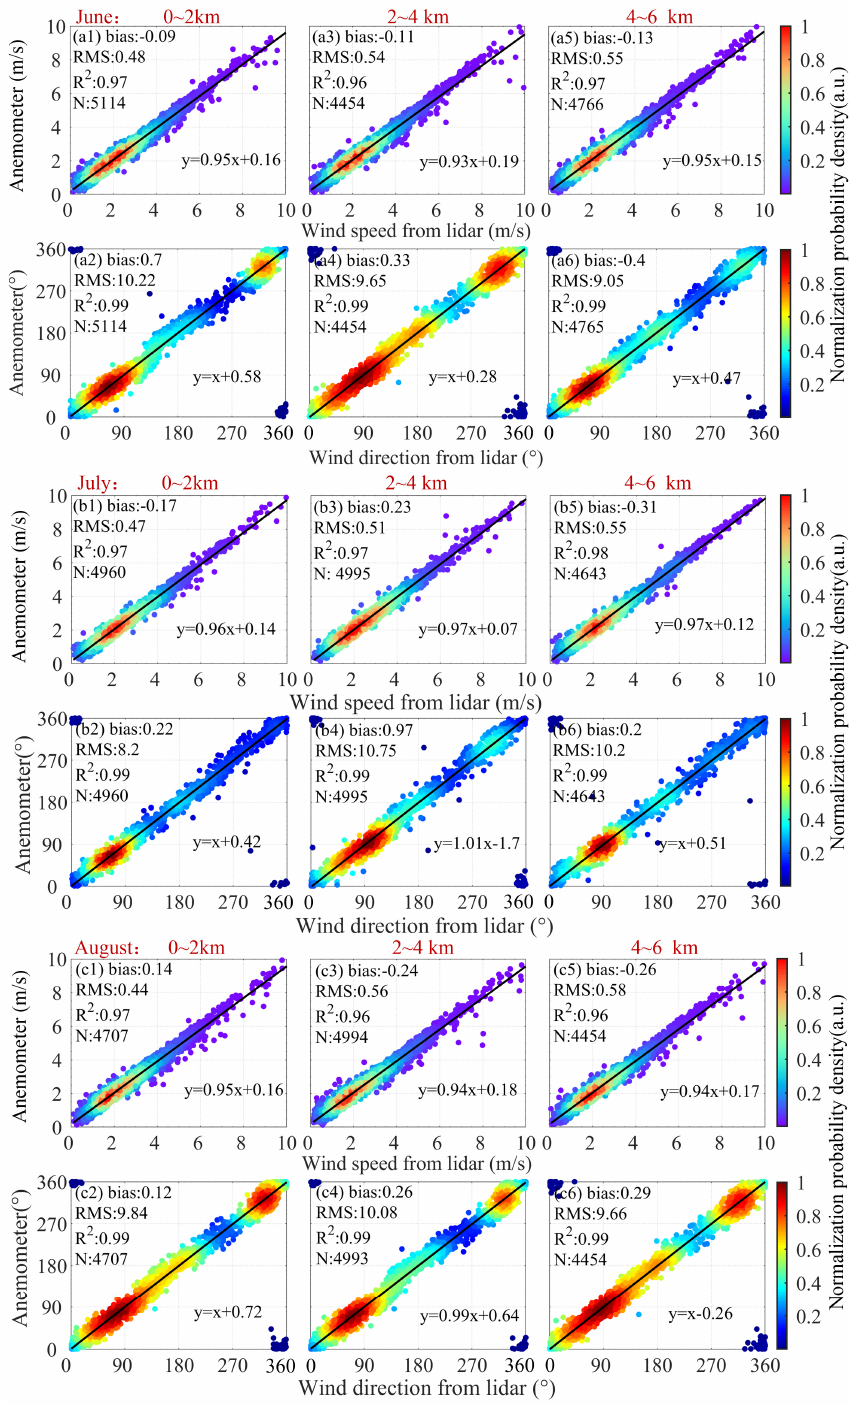
Figure 3. Comparison results of wind speed and direction measured by anemometers and retrieved from the CDWL. ( a1 – a6 ), ( b1 – b6 ) and ( c1 – c6 ) shows the comparison result of June, July, and August, respectively. The detail linear fitting results are also given in the figure. The color of each points represents the normalization probability density using the kernel density estimation. Positions of anemometers are marked in the head of each group of diagrams in red